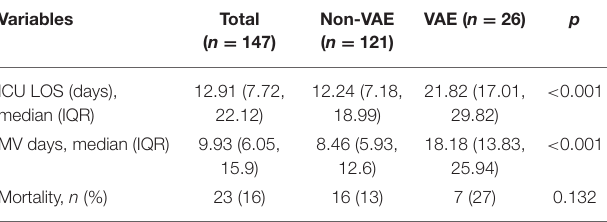
TABLE 2 | Clinical outcomes between VAE and non-VAE groups.